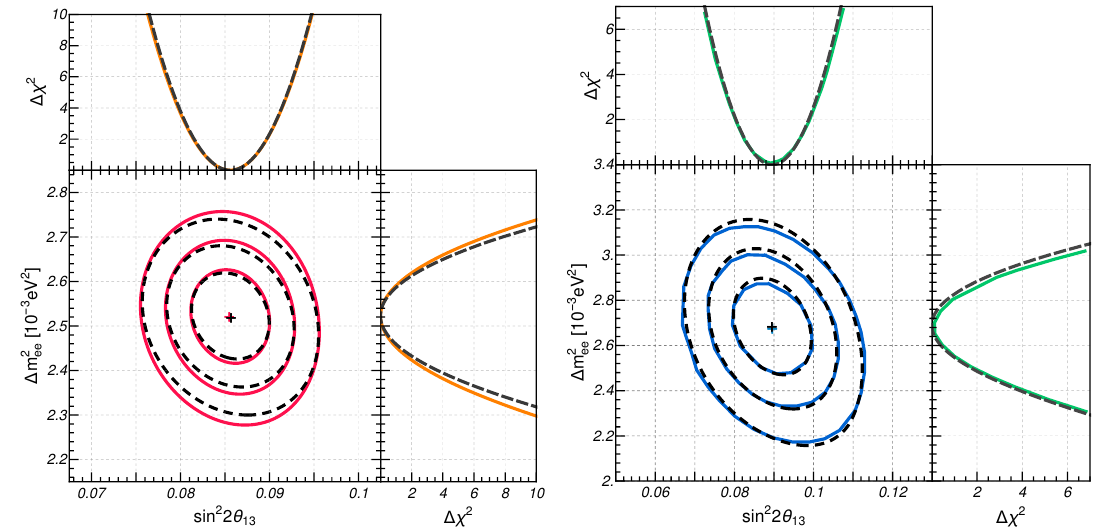
Figure 14 . Our (cid:12)t to DayaBay and RENO (black-dashed lines) compared to the results of the experimental collaborations (solid lines), as published in refs. [21] and [22], respectively, when adopting the same assumptions. Following the collaborations, on the vertical axes, the parameter (cid:1) m 2 de(cid:12)ned in eq. (3.10) is ee